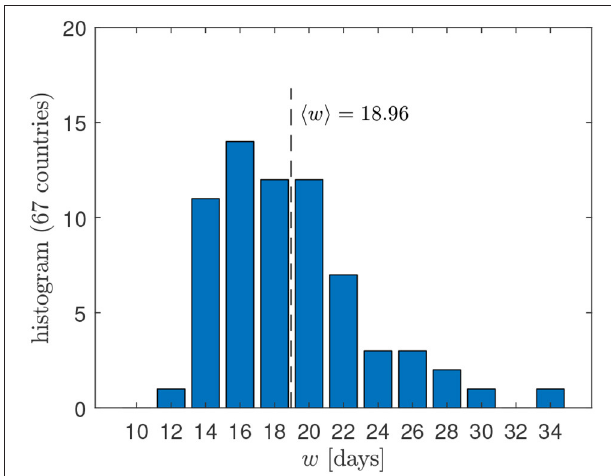
FIGURE 1 | Distribution of widths w obtained by the best fit of the GM to the death rates in 67 different countries [